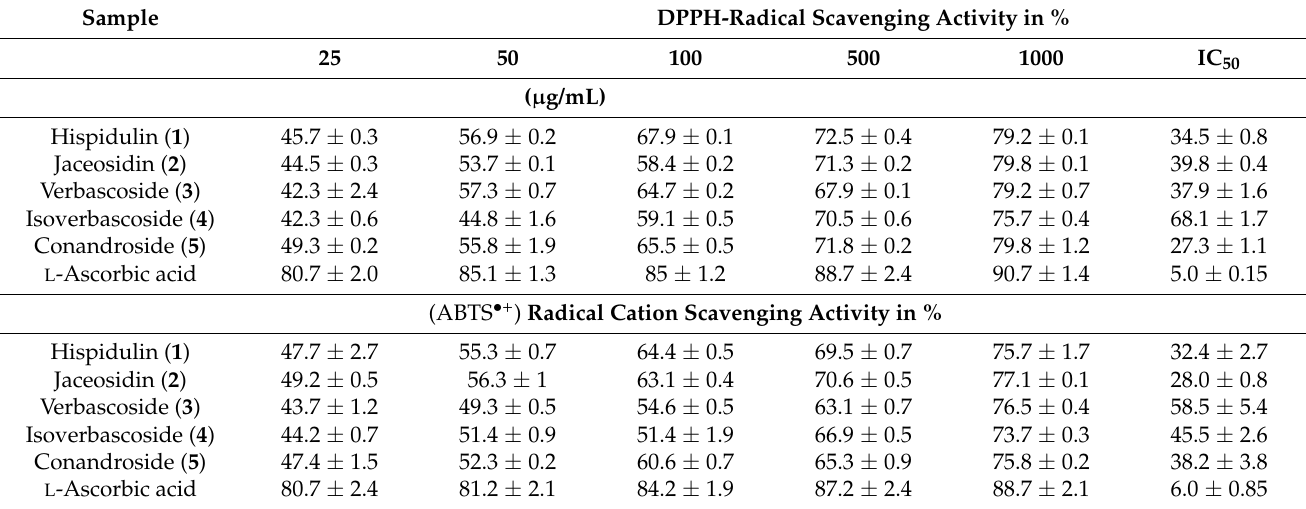
Table 2. Free radical scavenging activity of N. oppositifolia isolated compounds ( 1 – 5 ).